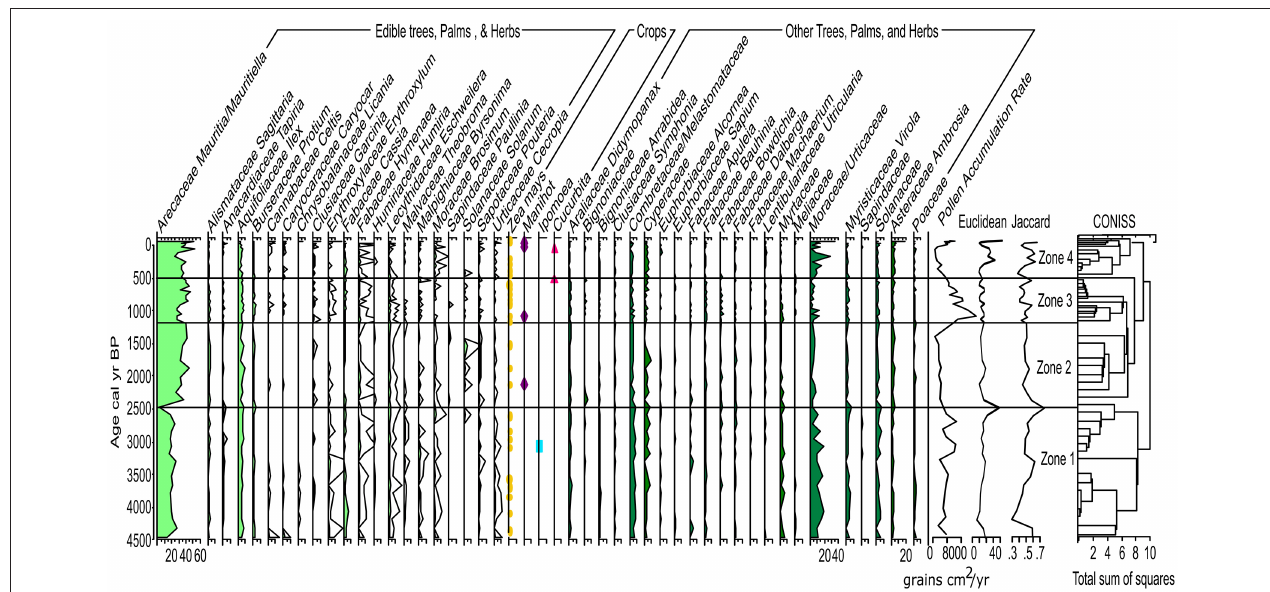
FIGURE 5 | Lake Caranã pollen data. Percentage pollen diagram (silhouettes show 10X exaggeration curves); Pollen Zones determined from CONISS. Light green represents edible plants, dark green represents other trees, palms and herbs, symbols represent total counts of crop pollen: yellow circle maize ( Zea mays ), blue square sweet potato ( Ipomoea ), purple diamond manioc ( Manihot ), pink triangle squash ( Cucurbita ). PAR, Euclidean, and Jaccard metrics data on the far right of the